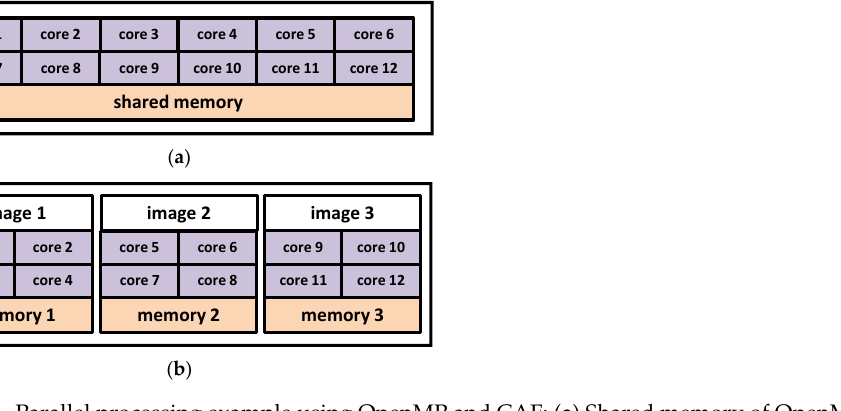
Figure 1. Parallel processing example using OpenMP and CAF: ( a ) Shared memory of OpenMP; ( b ) Distributed memory of CAF.